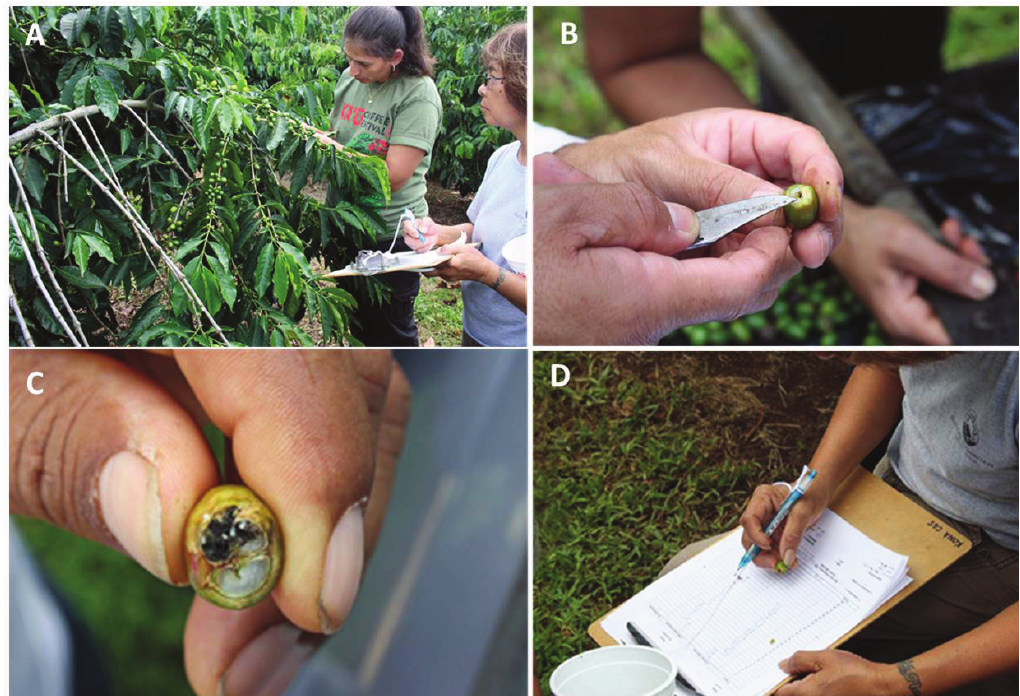
Figure 2. Evaluating the infestation levels of CBB ( A ), in position AB the CBB is vulnerable to insecticides ( B ); in the CD position CBB only can be controlled by removal of berries or natural enemies ( C ); recording the information ( D ). Photos taken in Pahala, Hawaii by Juan A. Aristizábal and Luis F. Aristizábal.